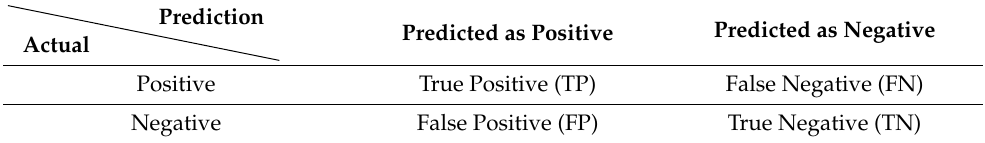
Table 1. Unnormalized confusion